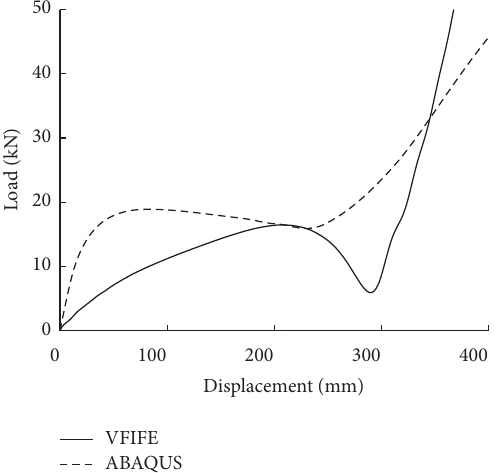
Figure 12: Load-displacement curves for center nodes of the shallow spherical shells.